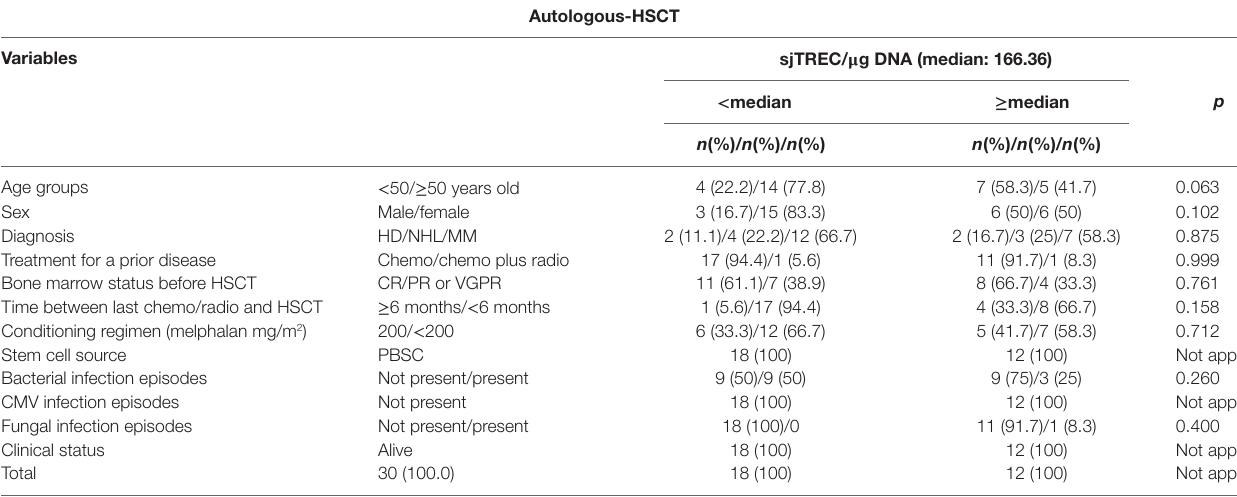
Table 6 | Characteristics of patients 9 months post-autologous hematopoietic stem cell transplantation (HSCT). autologous-hscT Variables sjTrec/ μ g Dna (median: